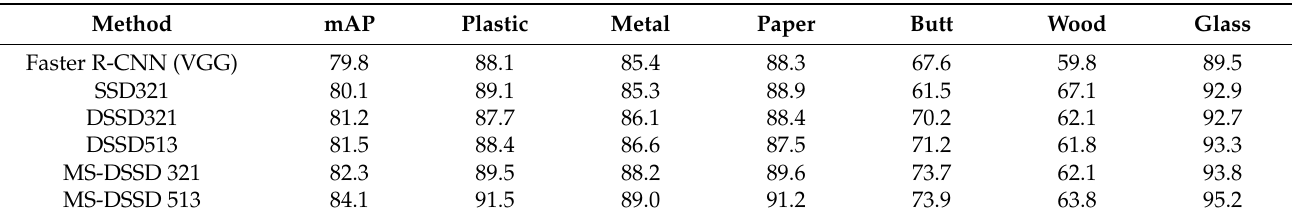
Table 3. IST-Waste-V2 Test detection